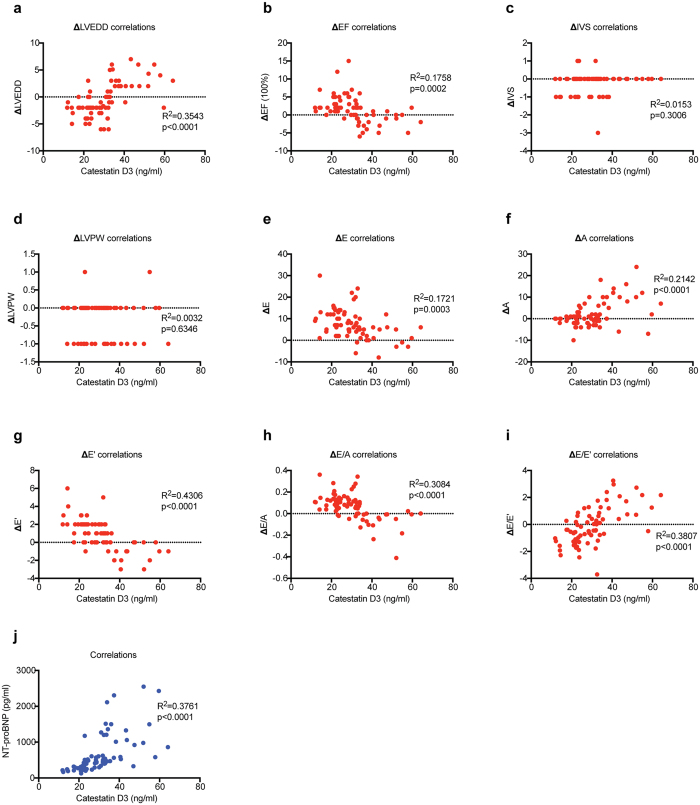
(a–i) Scatter plots (with Pearson or Spearman’s correlation coefficients) showing the correlation between catestatin concentrations at D3 and changes of echocardiography parameters including LVEDD, EF, IVS, LVPW, E, A, E’, E/A, and E/E’. j, Scatter plots showing the correlation between catestatin concentrations at D3 and NT-proBNP concentrations.